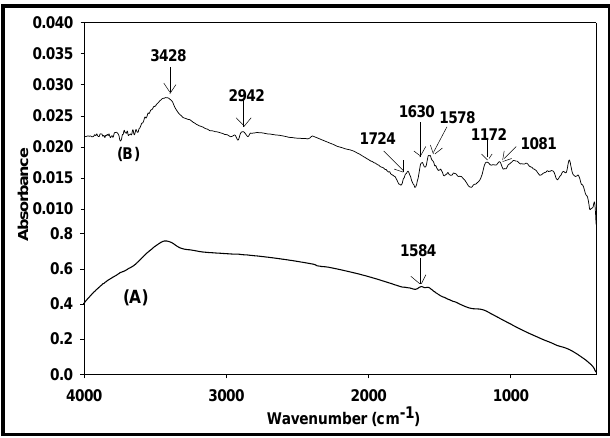
Figure 1. FTIR spectra: pristine ( A ) in comparison with-COOH functionalized ( B ) CNTs.